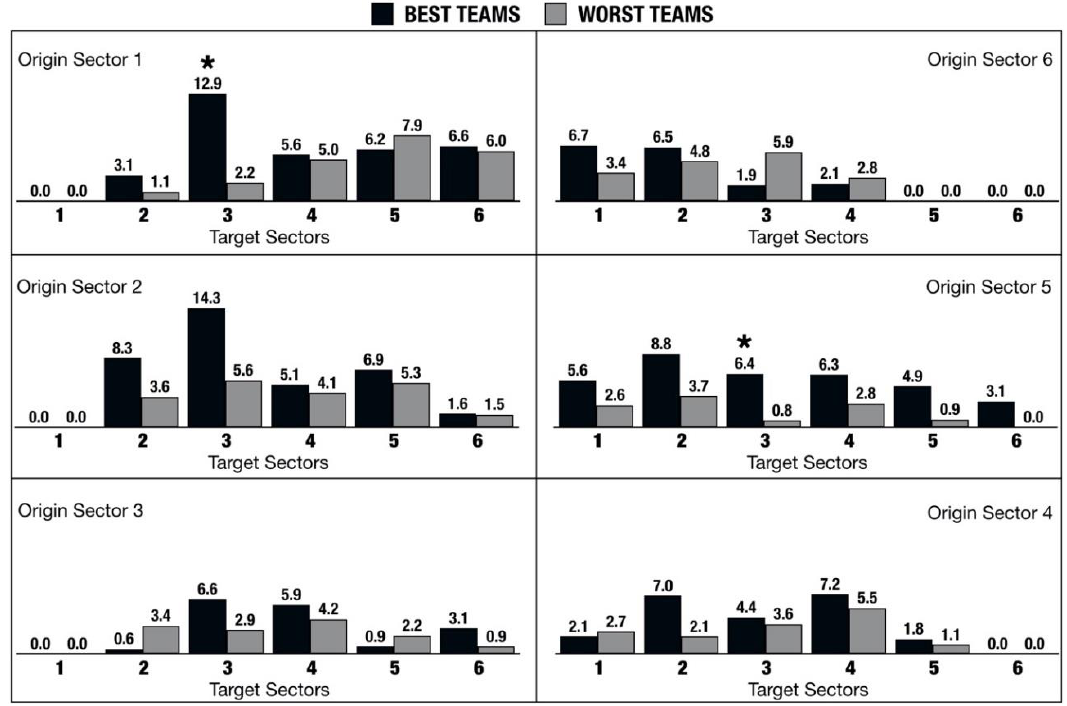
Figure 5 . Comparison of mean attack efficacy for best teams vs. worst teams. * p < .05; ** p < .01 *** p<.001. Note: in some cases, not exactly 100% due to